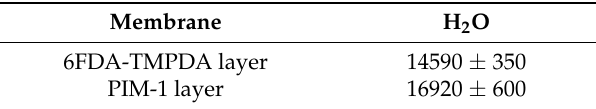
Table 8. Calculated water permeability (barrer) through composite membranes’ 6FDA-TMPDA and PIM-1